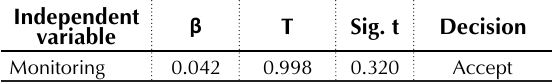
Table 8. Results of a simple linear regression analysis to test the seventh sub-hypothesis ( H07 ) Independent